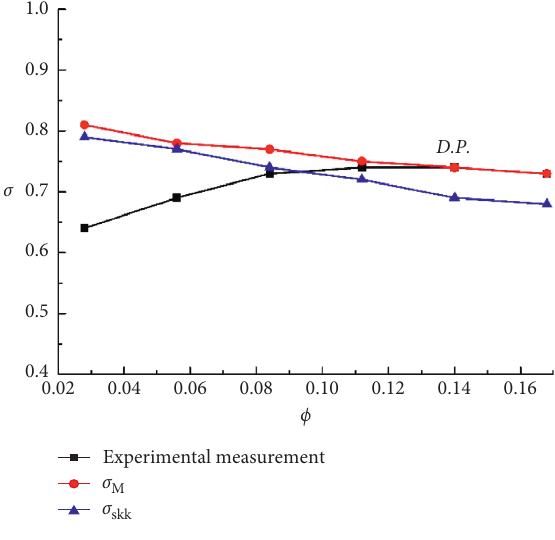
Figure 16: Slip factor at different flow